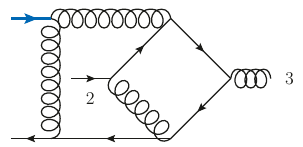
Figure 9. The QCD Feynman diagram that contributes to the fifth topology in figure 7.